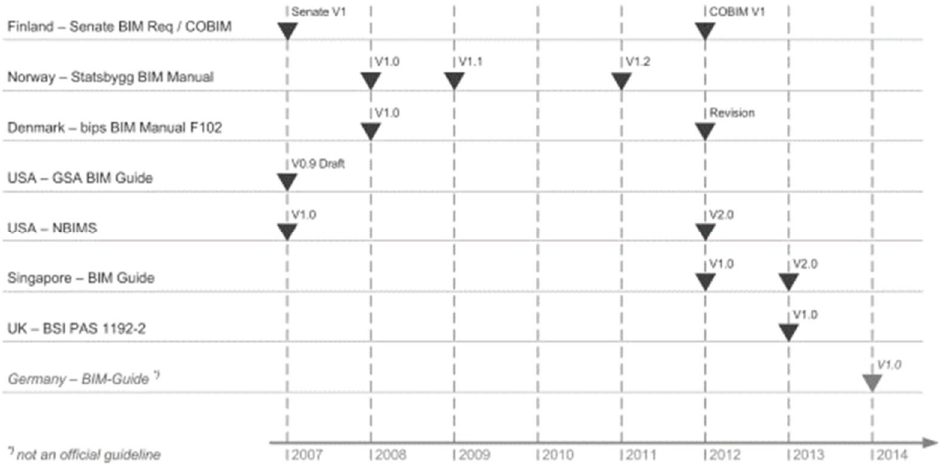
Figure 3. The guidelines publications.